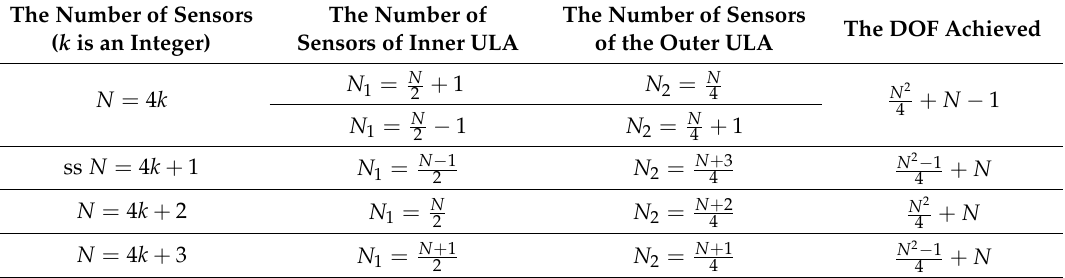
Table 1. The relationship between the number of sensors and DOF of